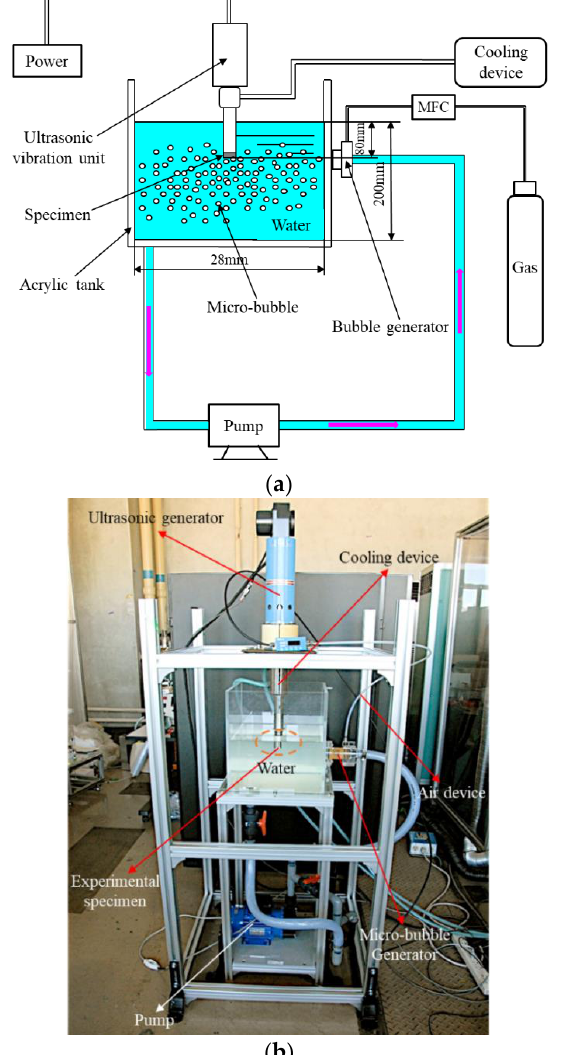
Figure 3. Schematic diagram and real object of ultrasonic erosion test equipment. ( a ) Schematic diagram of ultrasonic erosion test equipment, ( b ) Real object of ultrasonic erosion test equipment.